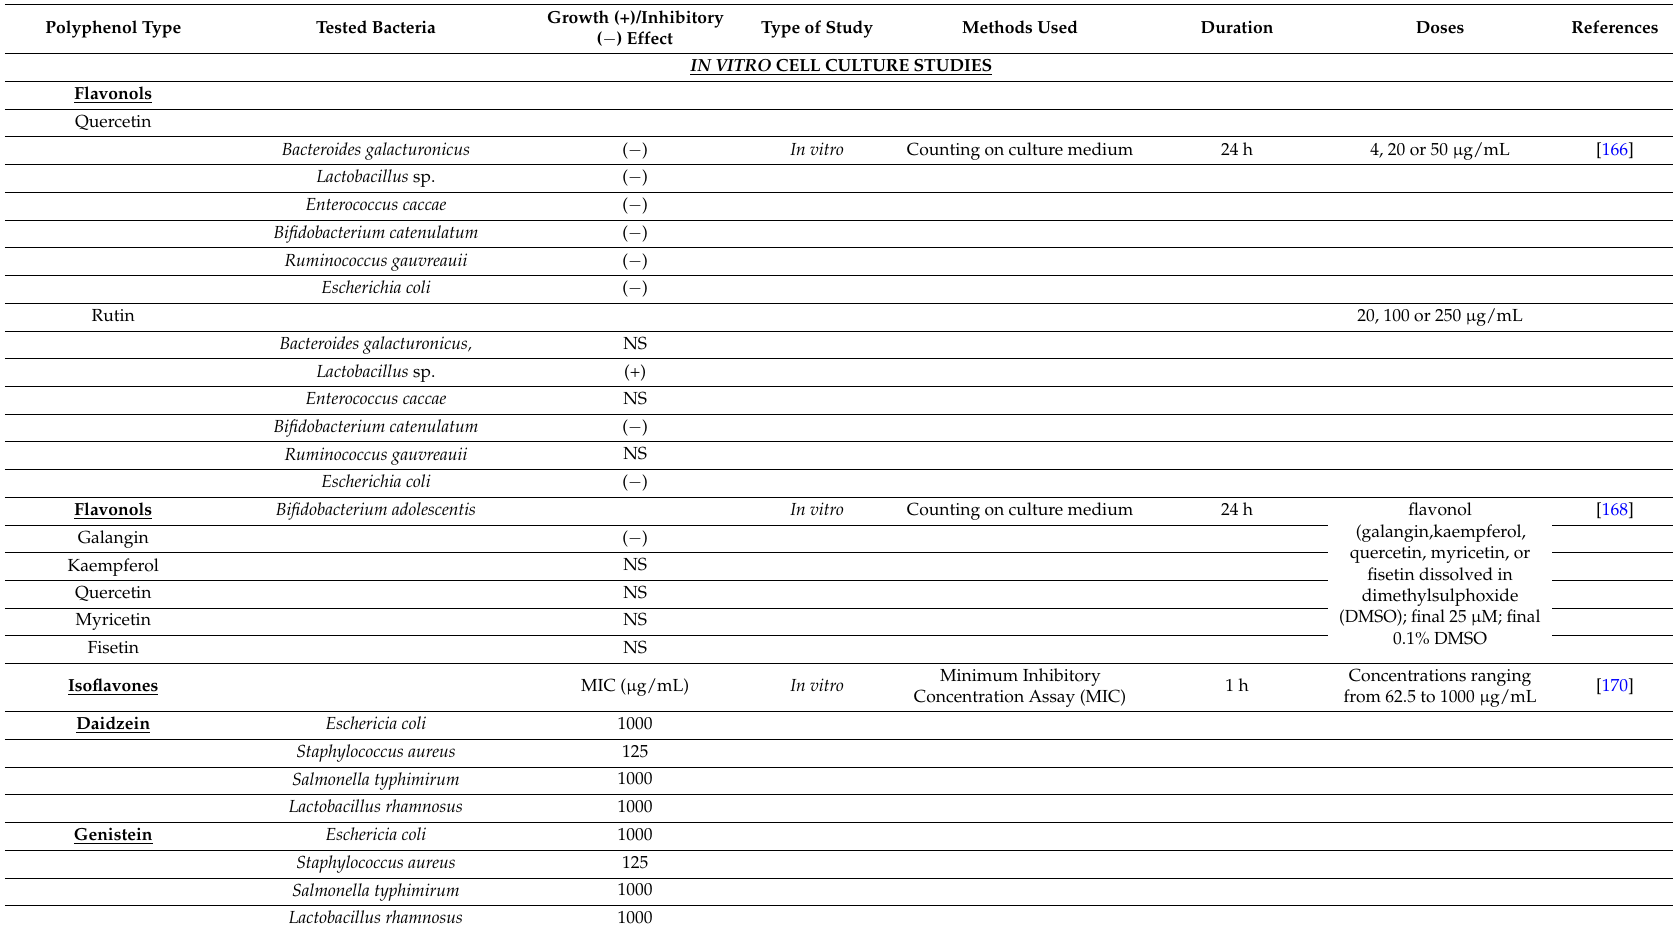
Table 3. Influence of phenolic compounds in gut microbiota